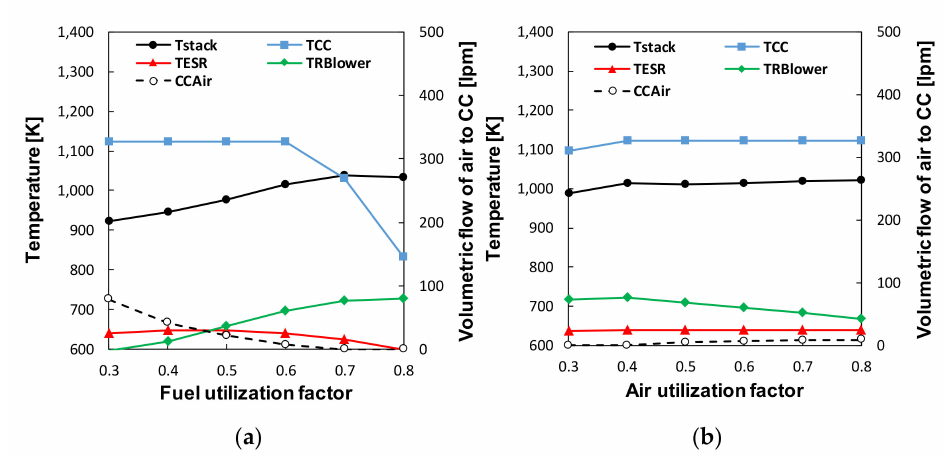
Figure 6. The effect of ( a ) fuel and ( b ) air utilization factors on the AOGR #2 system.